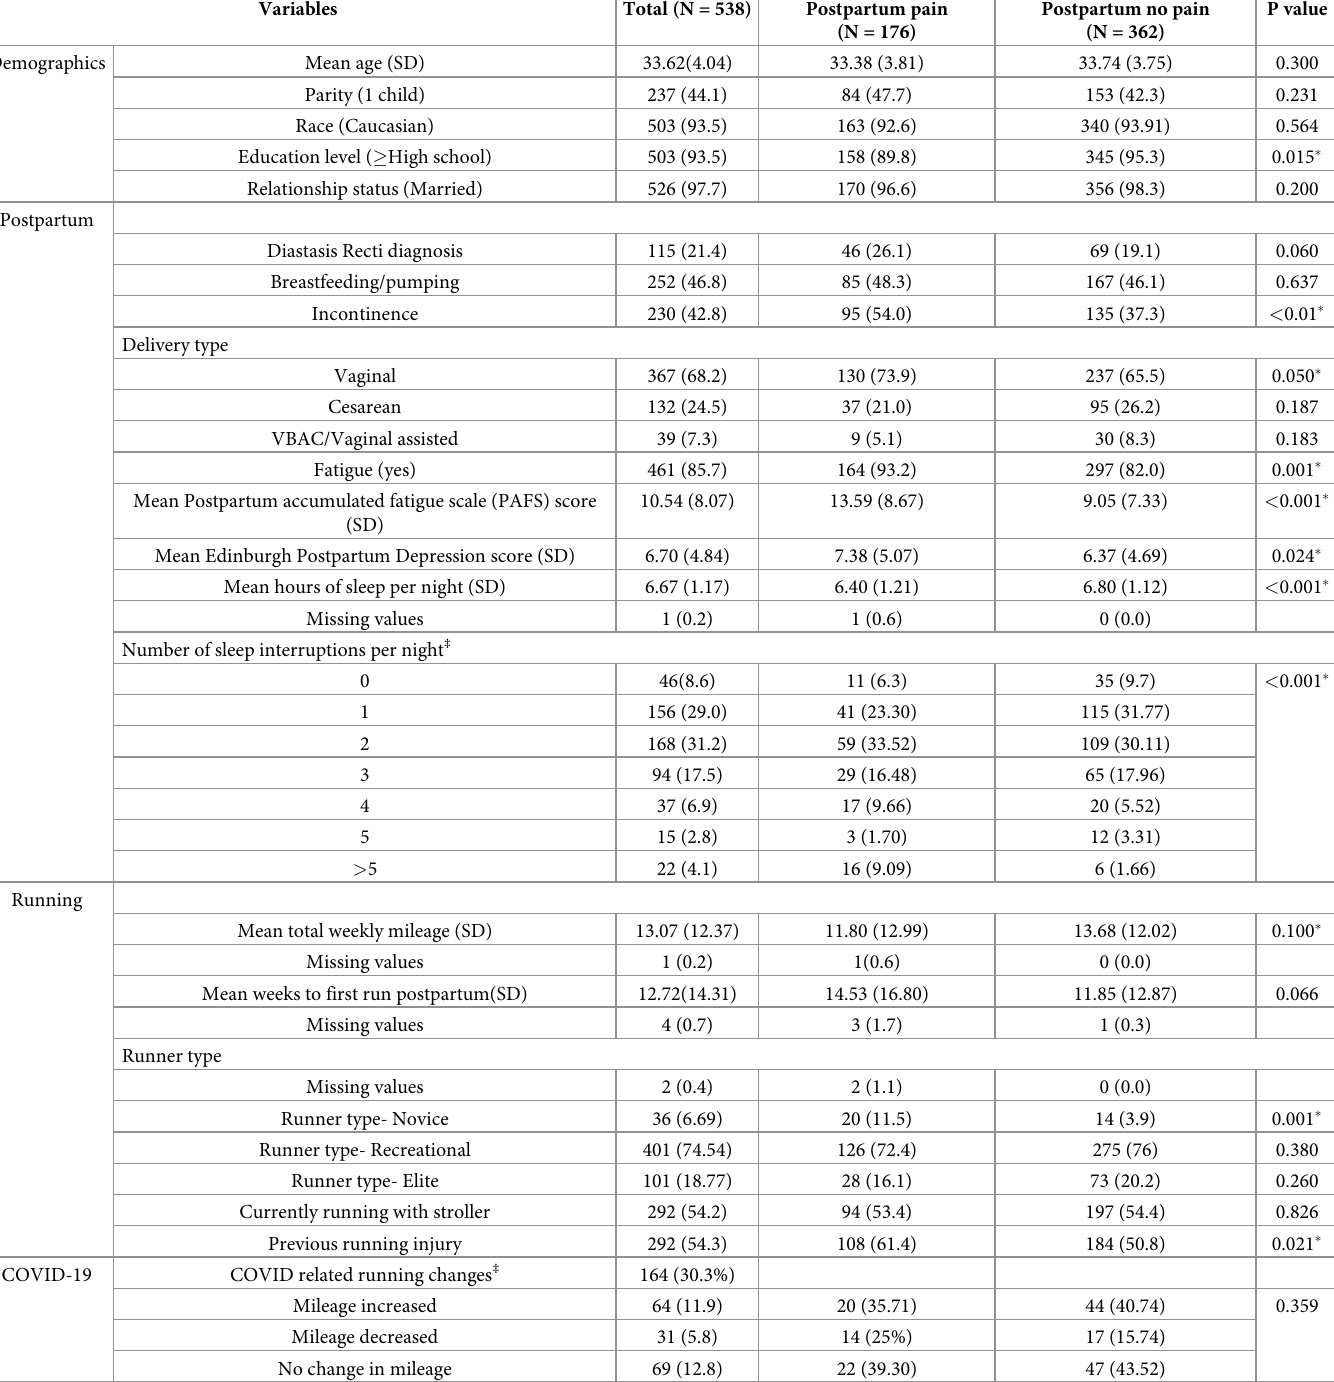
Table 1. Descriptive statistics for demographics, postpartum, running and COVID-19 related factors between postpartum runners with (N = 176) and without self- reported running-related pain (n =